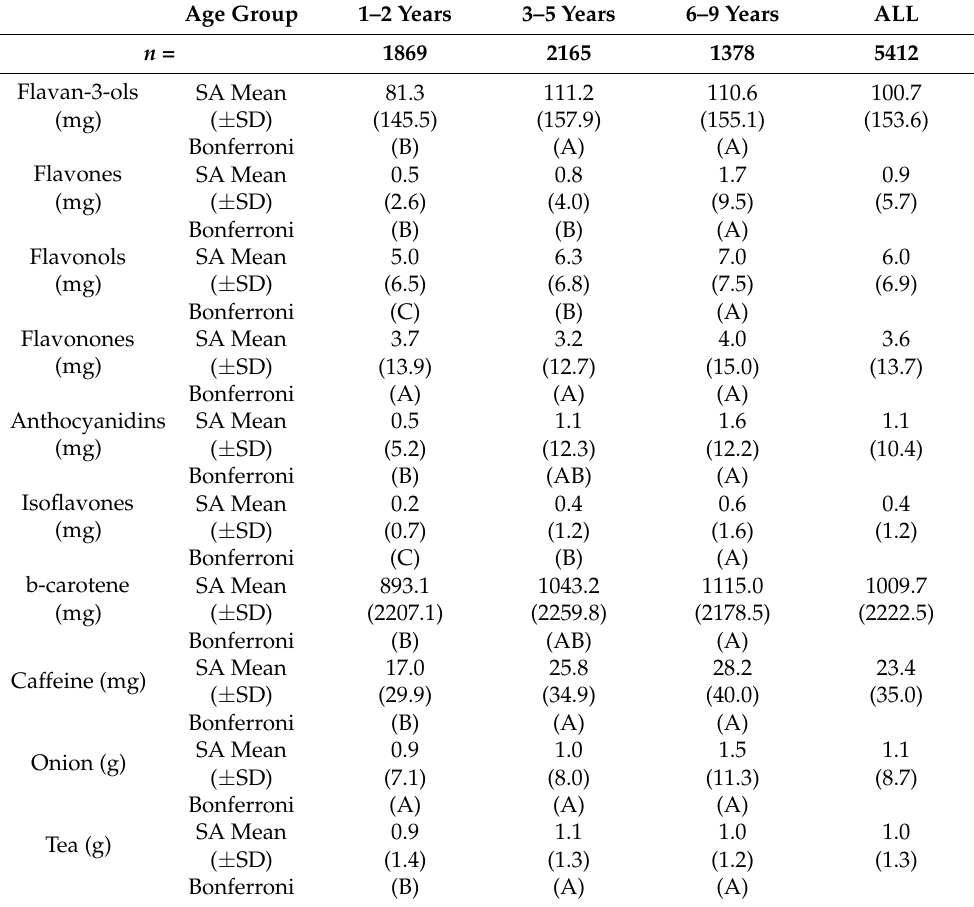
Table A4. South African child mean ± SD intake of flavonoids and other food parameters by PDIS age groups.